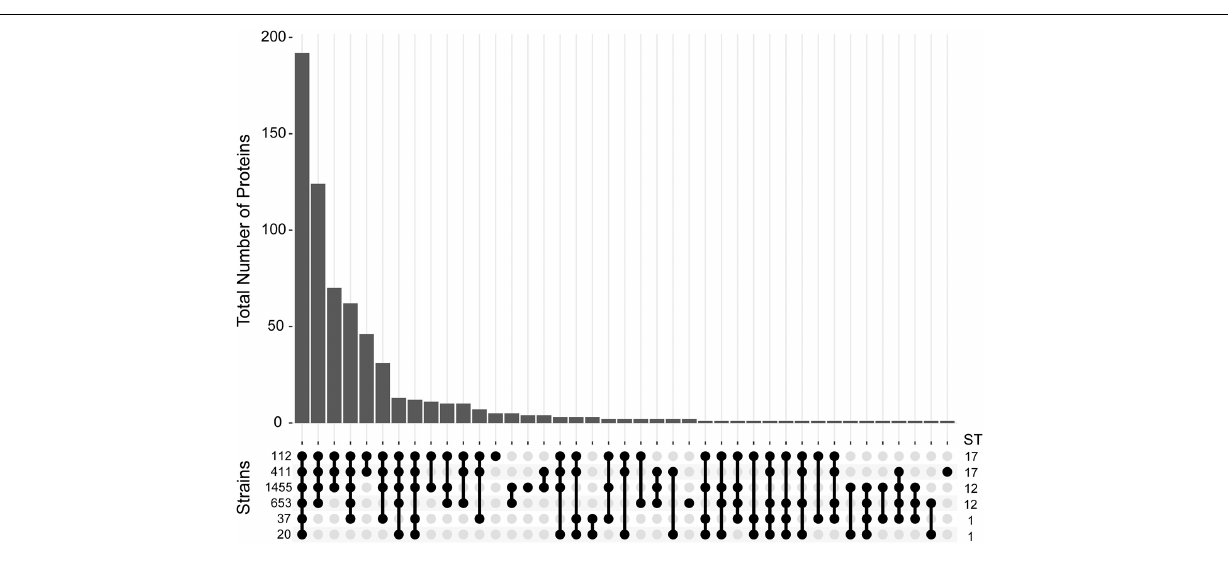
FIGURE 5 | Distribution of proteins detected in membrane vesicles (MVs) among six strains. An Upset plot was generated to show the distribution of all 643 proteins detected across the six GBS strains examined. The y -axis indicates the total number of proteins detected for a given set of strains. Protein presence is defined as having a non-zero spectral count for a given protein in at least one biological replicate for a specific strain. The matrix at the base of the plot shows the strains ordered vertically by sequence type (ST) with filled bubbles indicating which strains are positive for the number of proteins detected, and overlaid bars representing number of shared